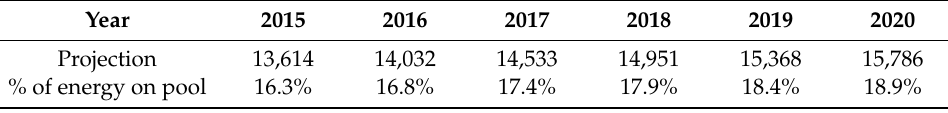
Table 5. Projection of renewable energies (ktep) 2015–2020 (Authors’ calculation).